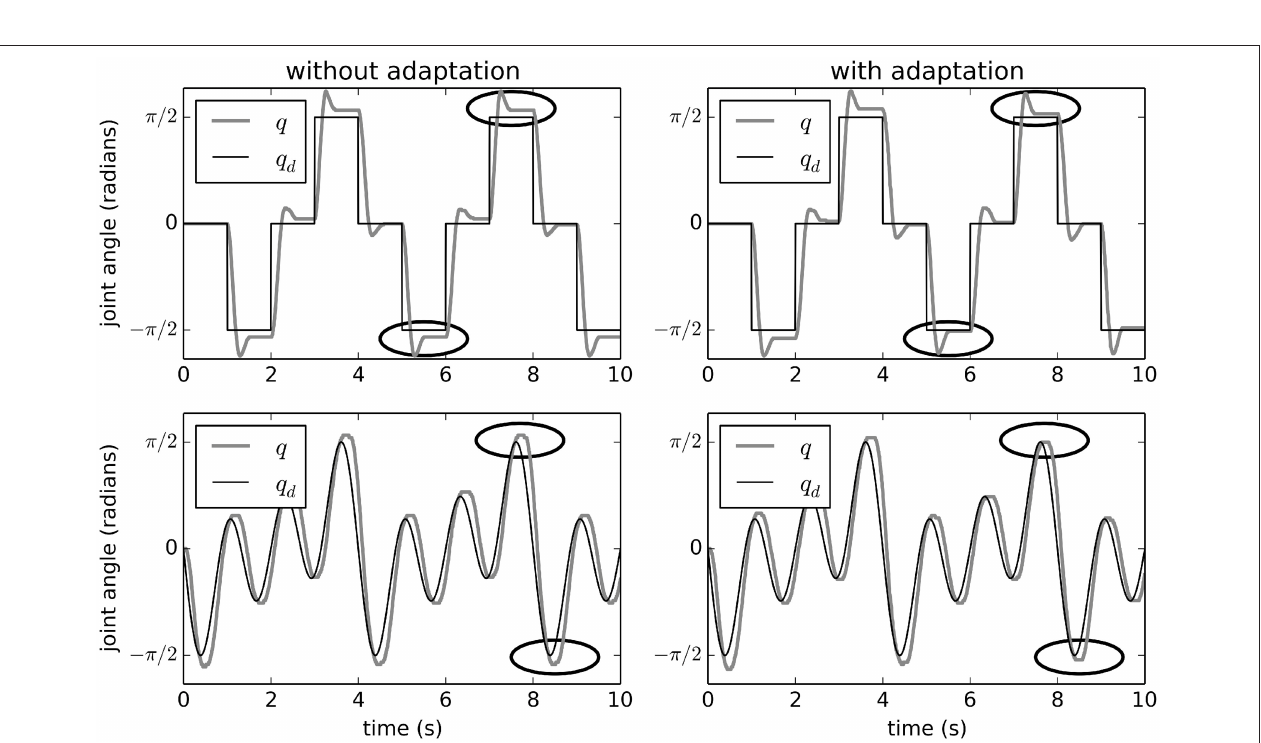
FIGURE 3 | Adaptive control of the EV3 lego robot used for calibrating the minimal simulation. The effects of adaptation over two different desired trajectories are shown. Without adaptation, the joints q do not reach the desired q d when q d is large (which is when the external force is largest). With adaptation, q is closer to q d after about 5s, showing that the system has quickly learned to compensate. Points in time where the improvement is clearest are circled.